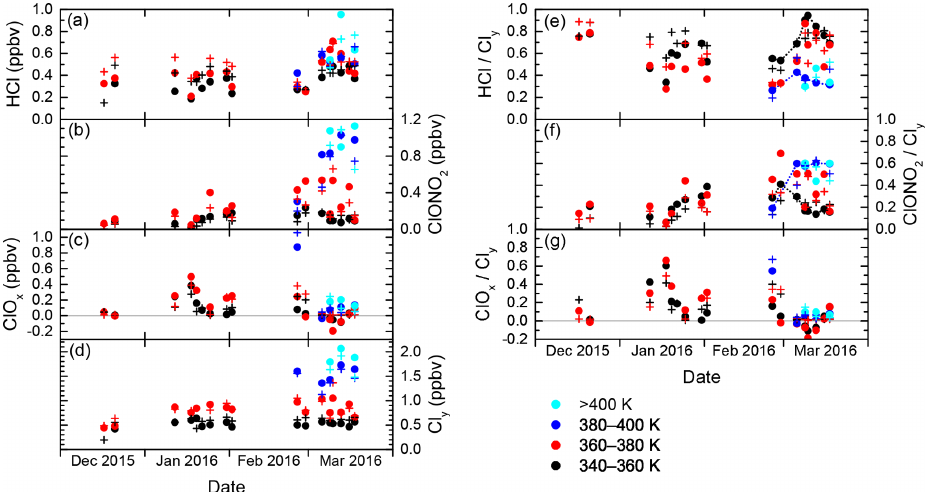
Figure 8. Similar to Fig. 6. In addition to averages from the measurements depicted as points, crosses denote averages from CLaMS model data interpolated at the flight track.